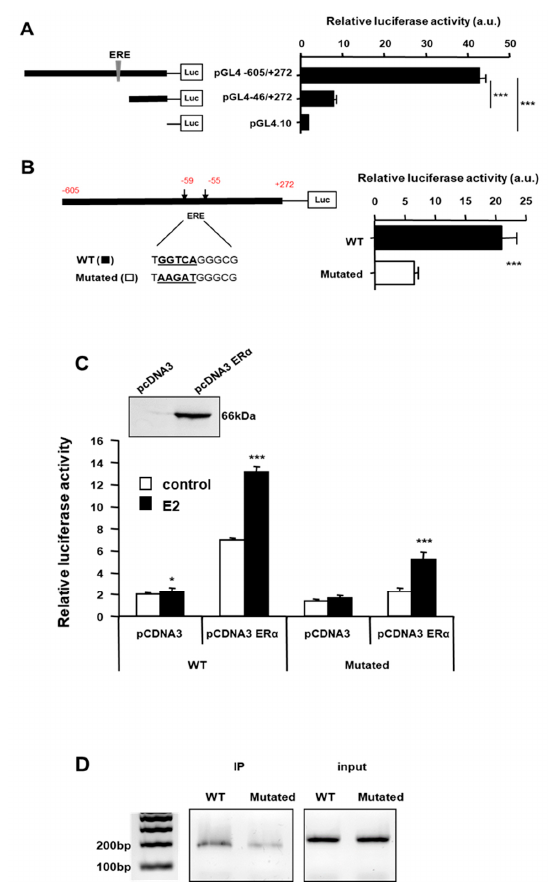
Figure 3. The activity of the SigR1 promoter. Relative luciferase activity was quantified in Huh7 cells after transfection with a reporter gene luciferase under the control of the SigR1 promoter, with or without the part containing the putative ERE ( A ) and with or without a mutated ERE ( B ). ( C ) HepG2 cells were transfected or not with ER1 α (+/ − pcDNA3 ER α ) and then stimulated (solid bars) or not (empty bars) with E2. Luciferase activity was quantified with the Wild Type (WT) or mutated (Mutated) SigR1 promoter. ( D ) Chromatine Immuno Precipitation on HepG2 cells transfected Wild Type (WT) or mutated (Mutated) SigR1 promoter. ( A – C ) Data are shown as mean ± SEM, * p < 0.05; *** p < 0.001, n = 6, Mann–Whitney U test. As expected, the mutation of the putative binding site for ER α on the SigR1 promoter abolished E2 effects on SigR1 expression, confirming that estrogens may act on SigR1 promoter through ER α . Inhibition was not complete, suggesting that there may even be at least one other ER α binding site on the Sig1 promoter. The binding of ER α on the ERE of the SigR1 promoter was confirmed using chromatin immunoprecipitation (ChIP) experiments in HepG2 cells transfected with SigR1 wild-type or mutated promoter and ER α (Figure 3D). As shown in Figure 3D, ER α can bind SigR1 promoter, but, when ERE is mutated, the binding is decreased, confirming the presence of a functional ERE on the SigR1 promoter. Taken together, our results demonstrate that estrogens induce the expression of SigR1 in hepatocytes via ER α .